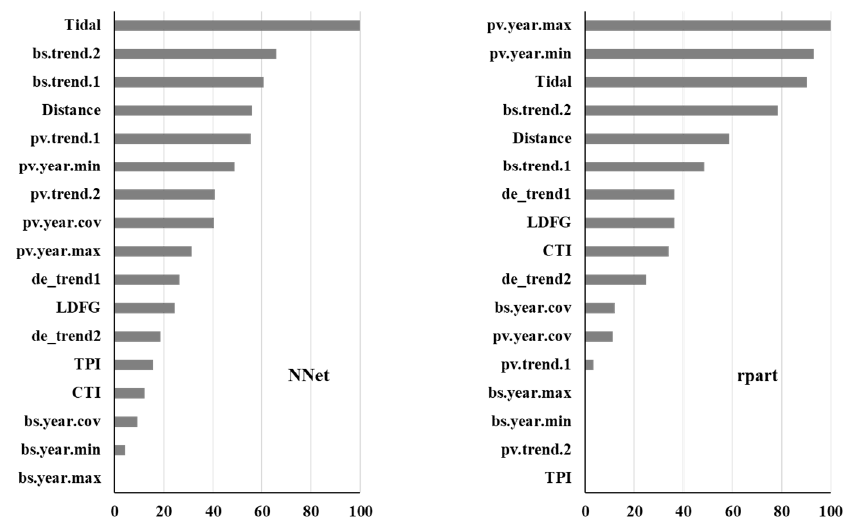
Figure 5. The importance of the predictor variables for selected classifiers. The importance value has been scaled to range between 0 and 100.